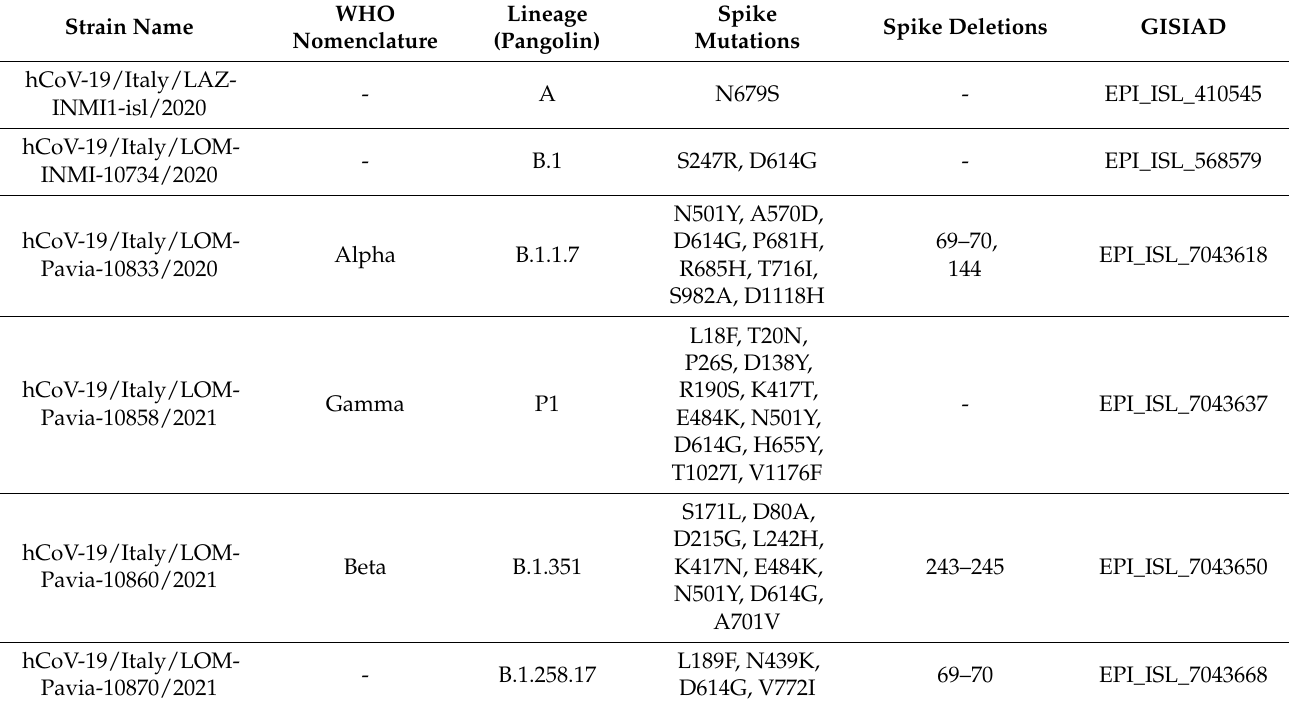
Table 2. Overview of the SARS-CoV-2 variants used in the study, reported with their corresponding mutations, the date of isolation, the lineage following Pangolin [10] and, where applicable, the WHO nomenclature